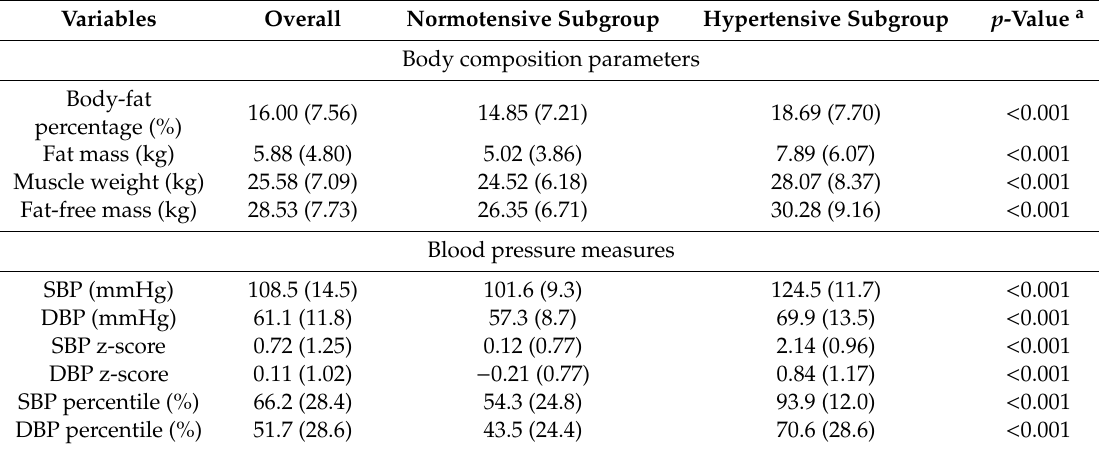
Table 2. Correlations a of blood pressure measures with demographic, anthropometric and body composition measures in the overall cohort.